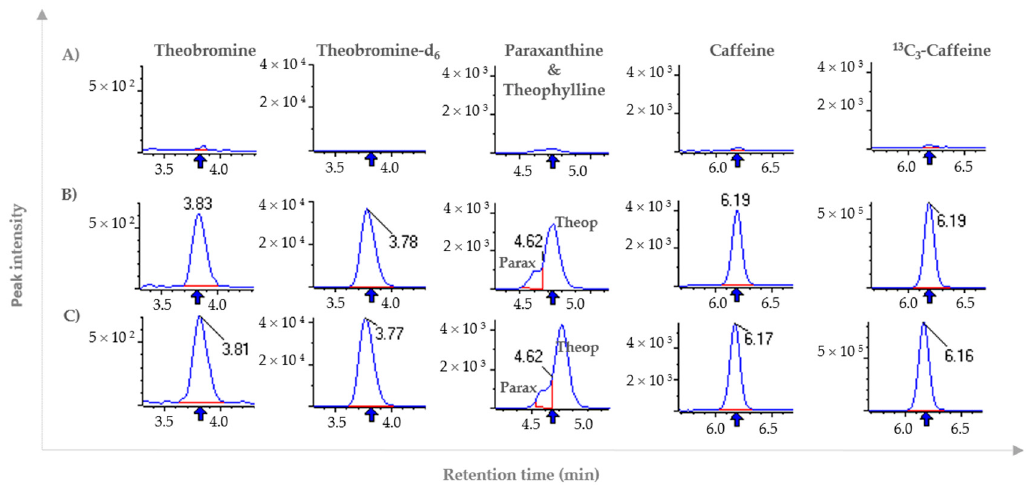
Figure 2. Extracted ion chromatograms corresponding to caffeine, theobromine, theophylline, paraxanthine and internal standards 13 C 3 -caffeine and theobromine-d 6 in ( A ) “blank” plasma samples, in ( B ) “blank” plasma spiked with each molecule and ( C ) pure solutions of each compound.